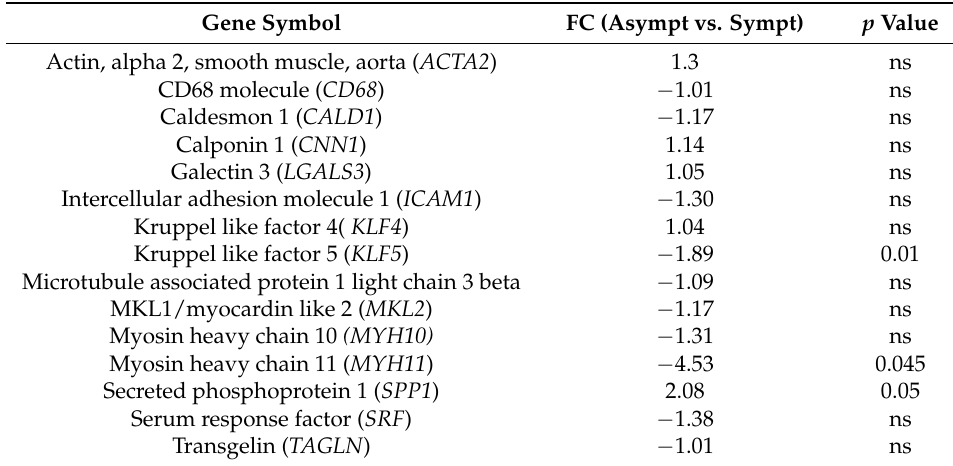
Relative gene expression analysis between 20 symptomatic (SYMPT) VSMCs and 19 asymptomatic (ASYMPT). Gene expression was normalized with the housekeeping genes GAPDH and RPL41 . Differences between the two groups were analyzed with Mann–Whitney U Test. p -value ≤ 0.05 was considered significant. (FC, fold